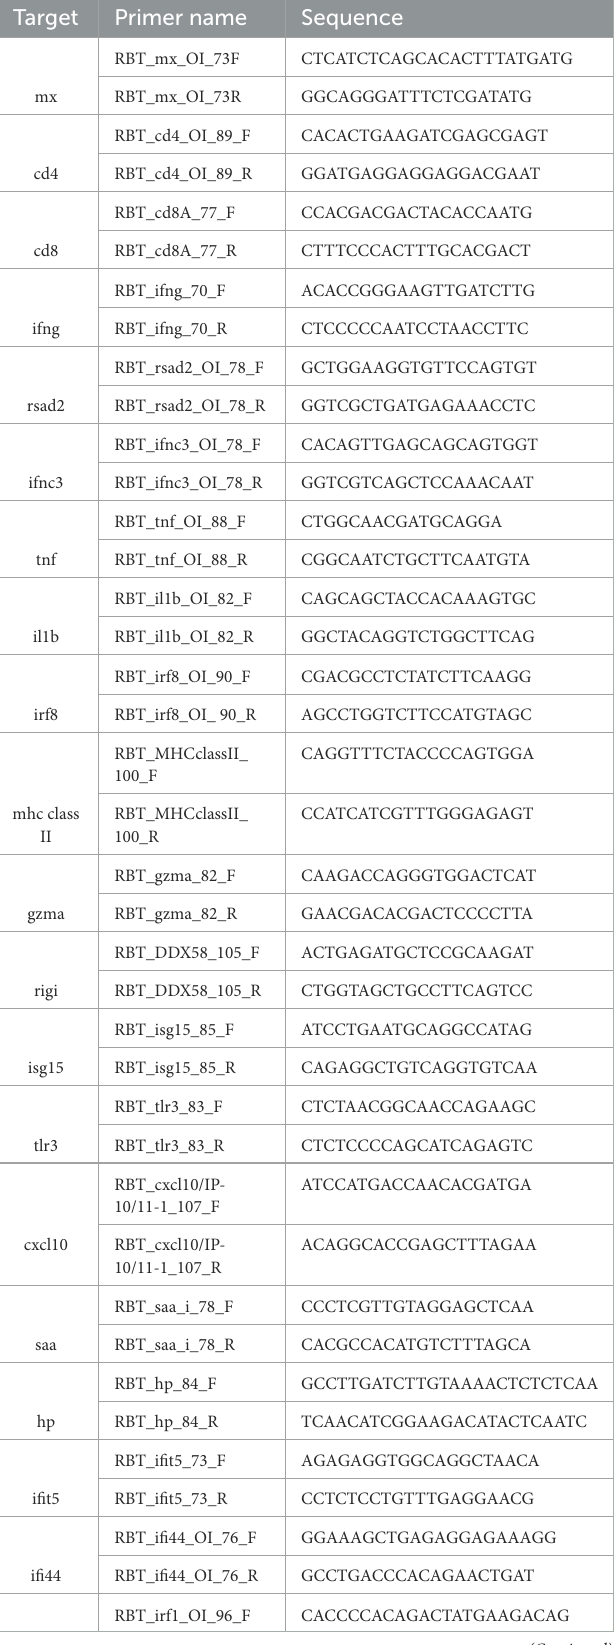
TABLE 3 Primers used for immune gene expression in spleen